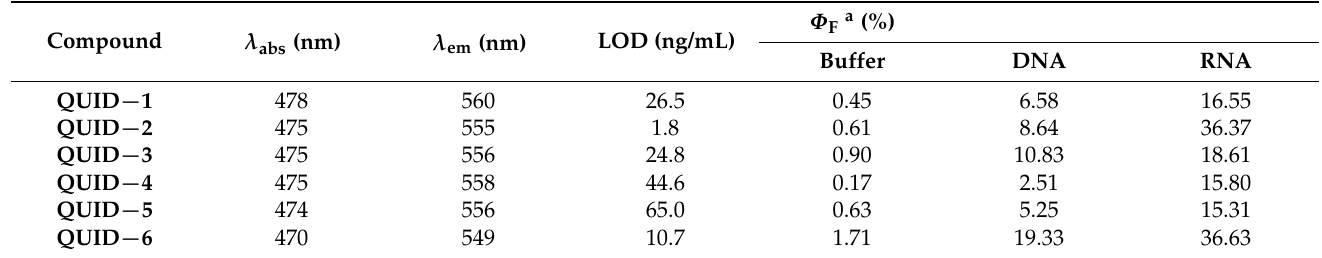
Table 1. The optical data, limit of detection (LOD) value of probes ( QUID − 1 – QUID − 6 ) for baker’s yeast RNA, and fluorescence quantum yields ( Φ F ) of probes ( QUID − 1 – QUID − 6 ) in the presence of salmon testes DNA or baker’s yeast